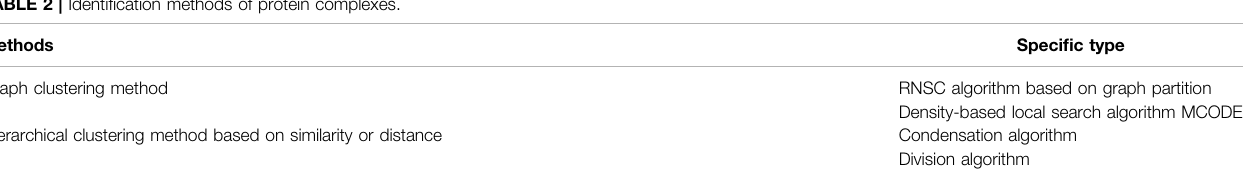
TABLE 2 | Identi fi cation methods of protein complexes.